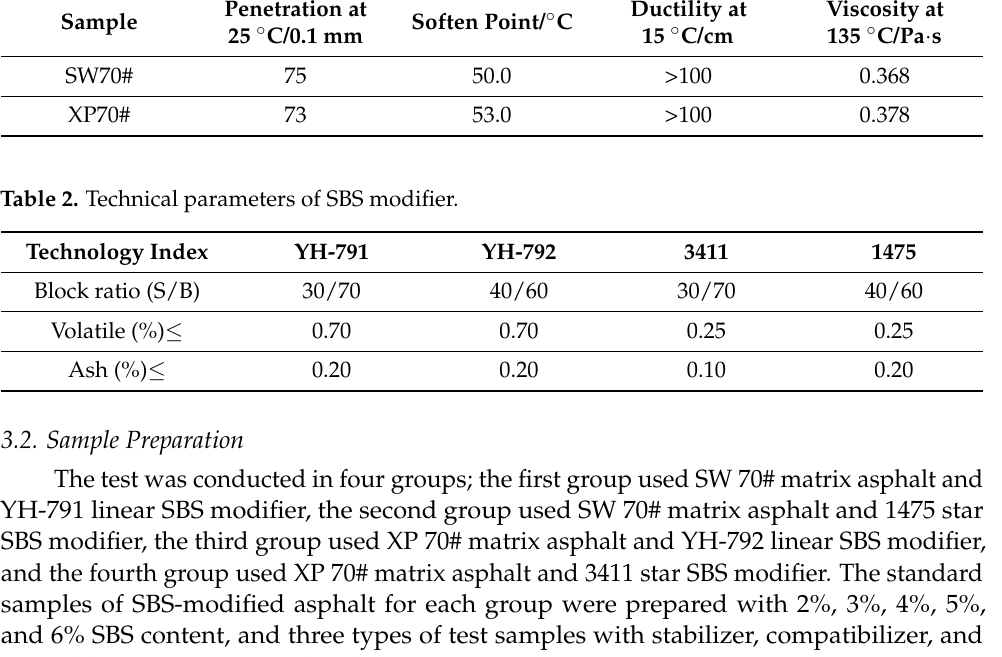
Figure 2. Infrared spectra of different types of SBS-modified asphalt with 4% content at 966 cm − 1 . As can be seen from Figures 1 and 2, the infrared spectra of the four types of SBS- modifier-modified asphalt were different. Taking the modified asphalt with 4% SBS con- tent as an example, the peak area of different modified asphalts at 966 cm −1 varies greatly. The concentration of the substance was directly proportional to the peak area; therefore, the content of SBS modifier was analyzed by the peak area at 966 cm −1 . To eliminate the error of using a single characteristic peak, the characteristic peak area at 1377 cm −1 of the base asphalt was calculated, and the SBS content was quantitatively analyzed by the peak area ratio (A966/(A966 + A1377)). The peak area value is the average of five test results. Methods of measuring peak areas: the peak area consists of troughs and crests. The peak area measurement should include the entire wavenumber range of the absorption peak. Baseline correction was required in the actual calculation to ensure the accuracy. Connecting the lowest points of the troughs on both sides of the absorption peak is the corrected baseline. The blue part in Figure 3a is the peak area before baseline correction, and the blue part in Figure 3b represents the peak area after baseline correction. ( a )